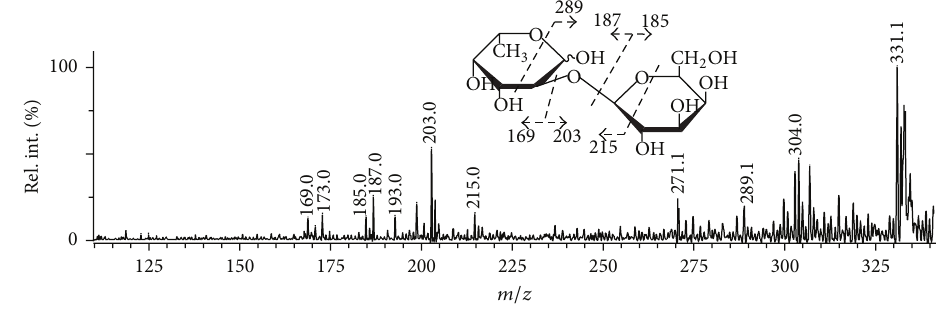
Figure 6: Positive-ion tandem MALDI-TOFMS ion at m/z 349.10.